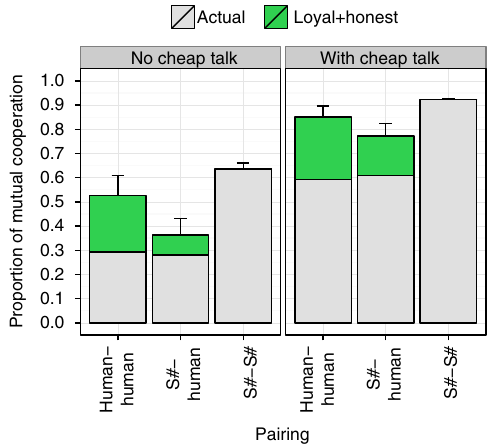
Fig. 8 The estimated impact of honesty and loyalty. The estimated proportion of rounds that could have resulted in mutual cooperation had all human players followed S# ’ s learned behavioral and signaling strategies of not deviating from cooperative behavior when mutual cooperation was established (i.e., Loyal) and keeping verbal commitments (i.e., Honest), and all other behavior from the players remained unchanged. See Supplementary Note 7 for details of methods used. Error bars show the standard error of the